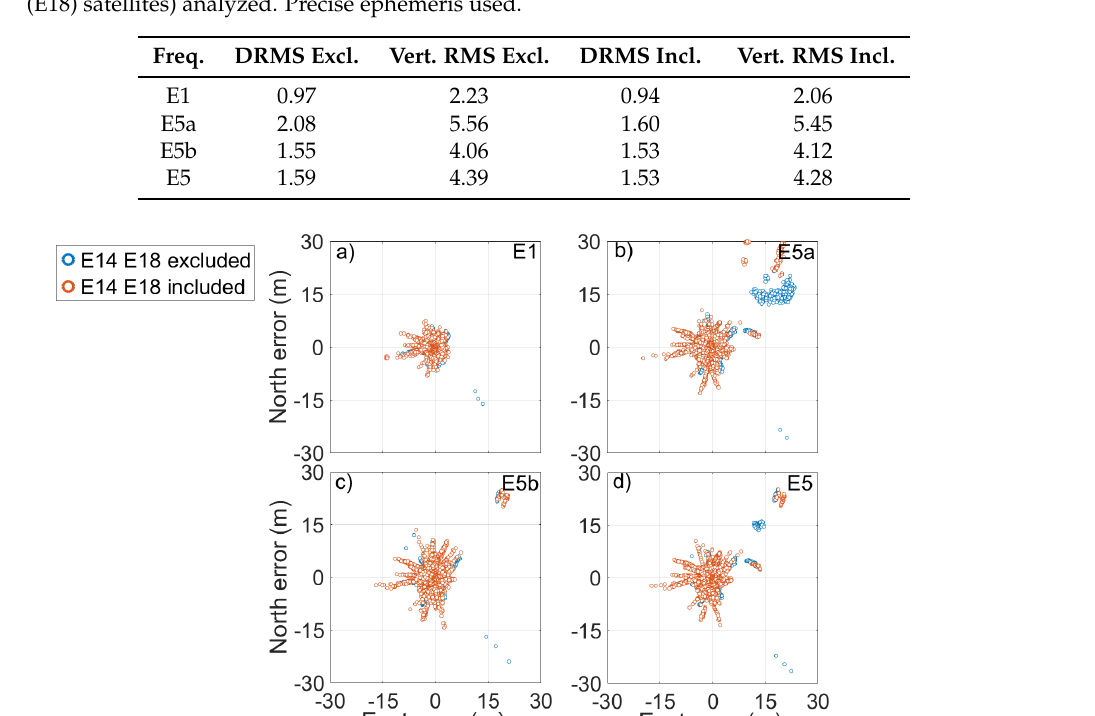
Figure 13. Scatter plot of the E1, E5a, E5b, and E5 single-point position error reported in ( a – d ). Blue and red markers represent errors when the solution was obtained by using excluding and including the measurements coming from the Milena (E14) and Doresa (E18) satellites, respectively. Solutions were achieved by using precise SP3 ephemeris.